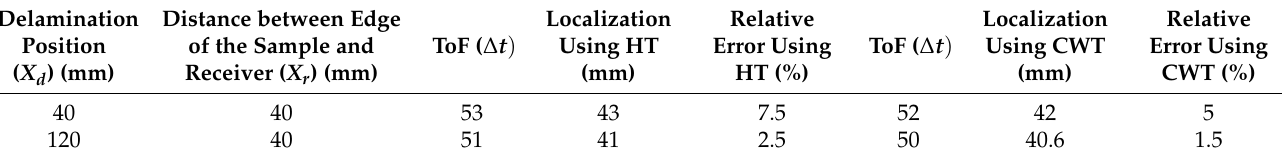
Table 8. Comparison of HT and CWT for damage location measurement.